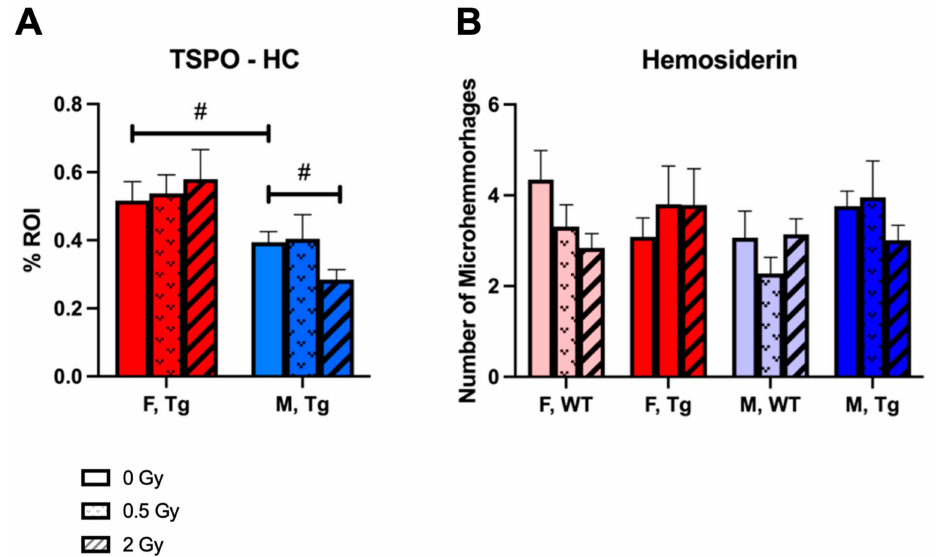
Figure 5. Proton irradiation modestly decreased gliosis in Tg male mice but not in Tg female mice and did not affect the number of microhemorrhages in either sex. ( A ): Immunohistochemical staining of microglial marker TSPO in hippocampus as a measure of gliosis. ( B ): Hemosiderin staining quanti- fied over near-midline sagittal whole brain slice to assess microhemorrhages ( n = 7–9 mice/group). #: p < 0.1. Data were analyzed by 2-way and 3-way ANOVA for TSPO and microhemorrhages respec- tively followed by post-hoc multiple pairwise comparisons using Tukey’s correction. Unirradiated control groups were compared by planned, 2-tailed t -tests independent of